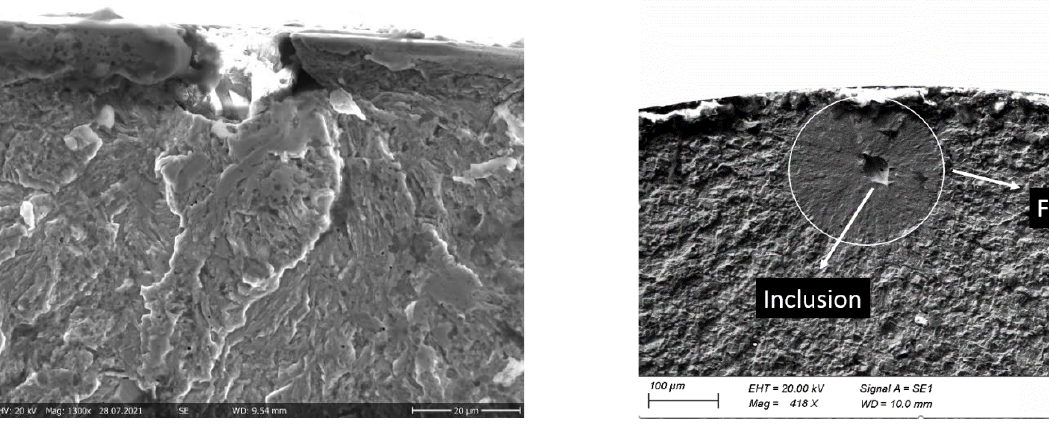
Figure 6. SEM images of two fracture surfaces: ( a ) crack initiation at a surface groove; ( b ) crack initiation at a critical inclusion inside the volume as well as the fisheye formation.